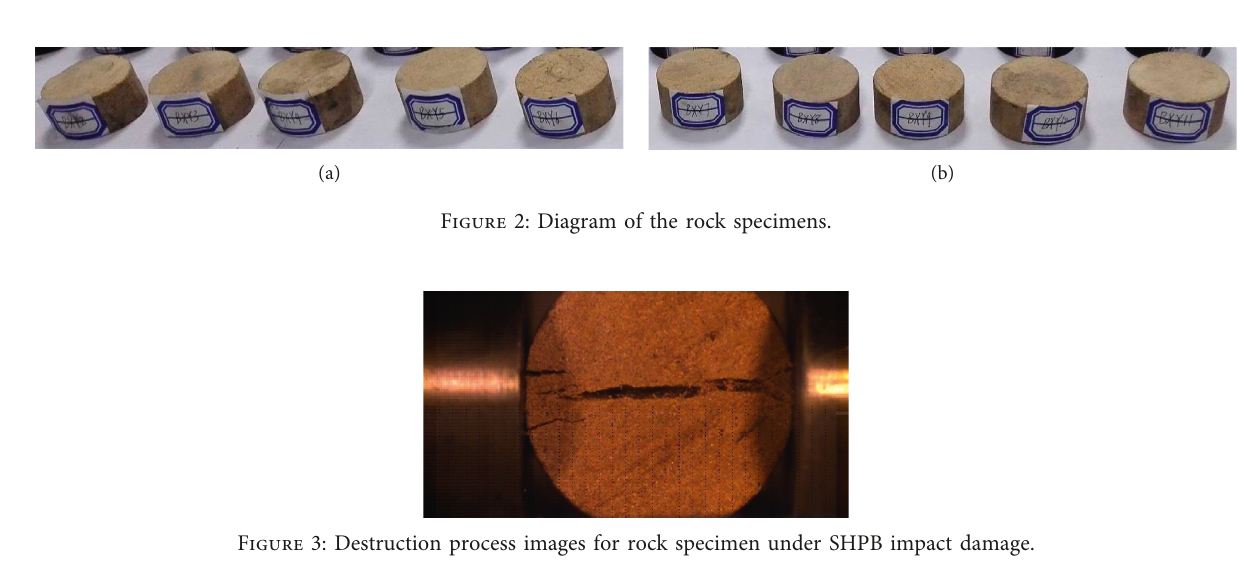
Figure 1: Schematic diagram of the SHPB experimental system.